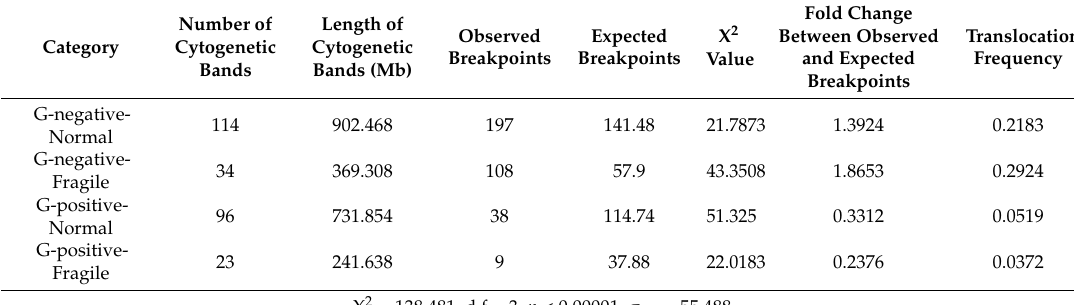
Table 8. Comparison of translocation breakpoints on cytogenetic bands divided by banding and fragility. Fold Change Length of Number of Observed Expected Between Observed X 2 Cytogenetic Category Cytogenetic Breakpoints Breakpoints and Expected Value Bands (Mb) Bands Breakpoints